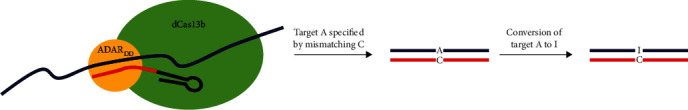
Engineering dCas13b-ADAR fusions for RNA editing. Schematic of RNA editing by dCas13b-ADARDD fusion protein which naturally deaminates adenosines to inosines in the target RNA. The crRNA specifies the target site by hybridization firstly, then creates a double strand RNA (dsRNA) structure and recruits the dCas13b-ADARDD fusion protein to deaminize. Besides, a mismatched cytidine in the crRNA is opposite the target adenosine which can enhance the conversion of target A to I.